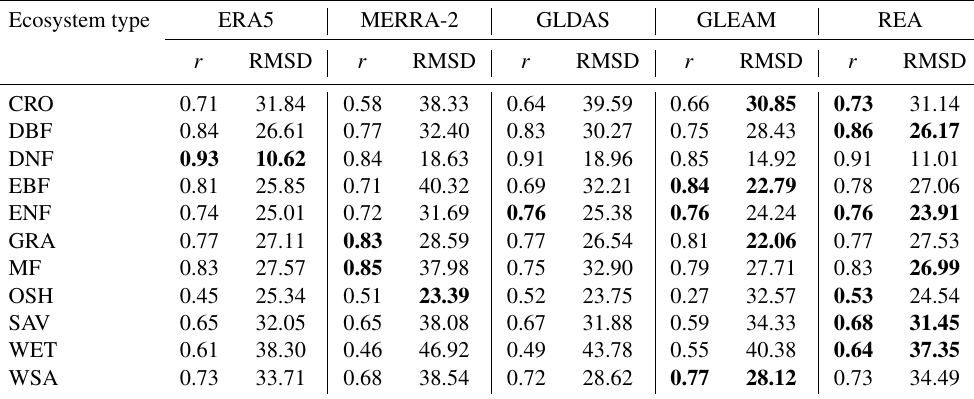
Table 3. The verification results including r and RMSD between monthly ground-measured ET and monthly ET from different products in different ecosystems. Values in bold indicate the highest